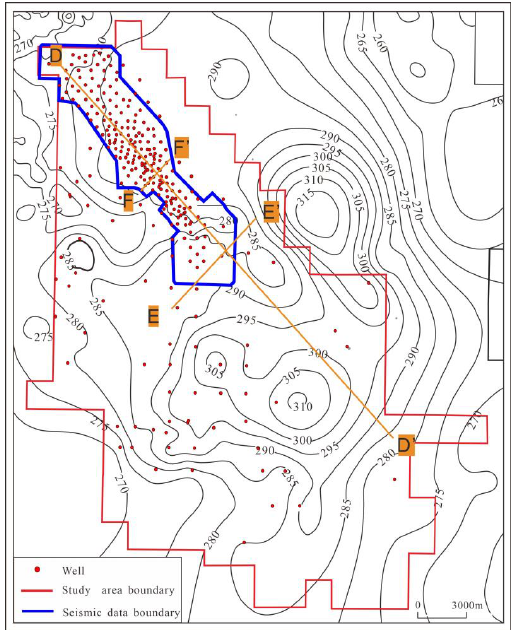
Figure 1. Structural diagram of the study area. DD’ and EE’ are the section location shown in Figure 10. FF’ is the 2D seismic section shown in Figure 9.